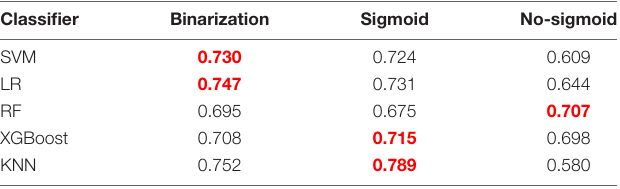
TABLE 1 | The mean F2-score for different feature sets and classification methods on the test set. Classifier